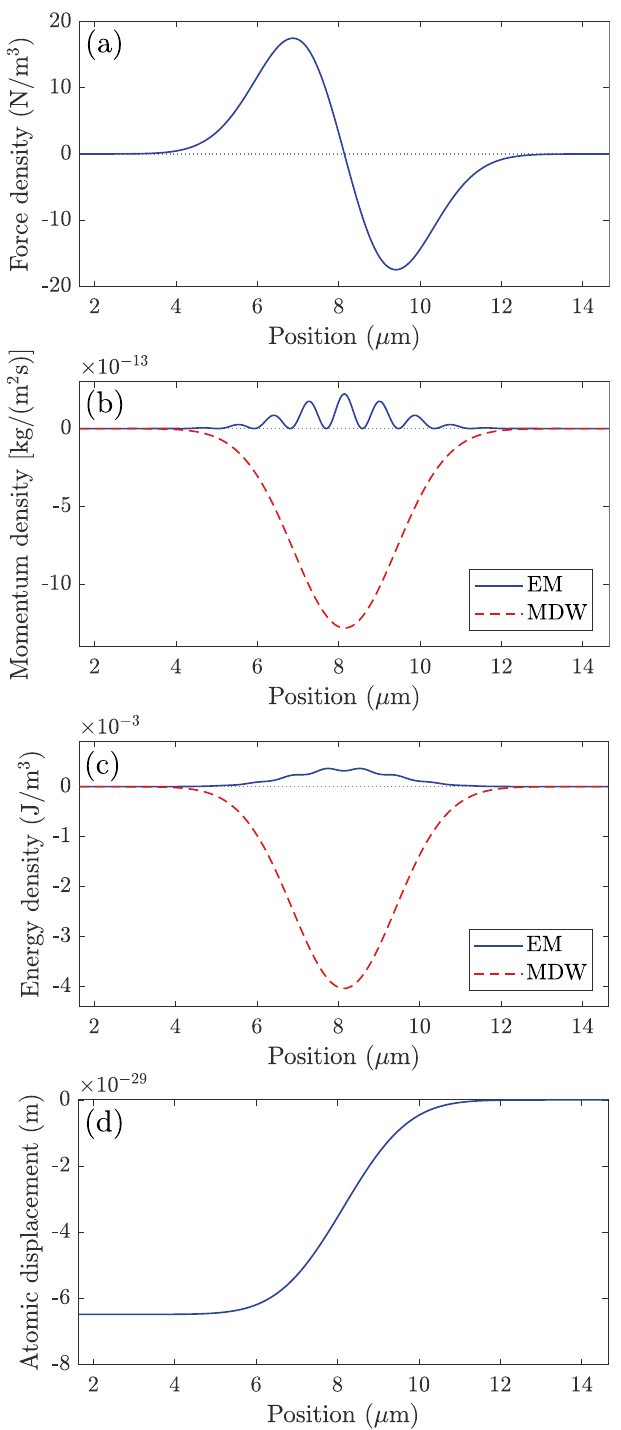
Figure 2. Simulation of light in a homogeneous NIM. The total energy and momentum of light are shared between the EM field and the material atoms. ( a ) Optical force density, ( b ) EM and MDW momentum densities, ( c ) EM and MDW energy densities, and ( d ) the atomic displacement for a one-dimensional Gaussian light pulse propagating to the right at a fixed instance of time. The atomic displacement is here very small, but it can be nanometers for pulses that are longer and have higher intensity 25